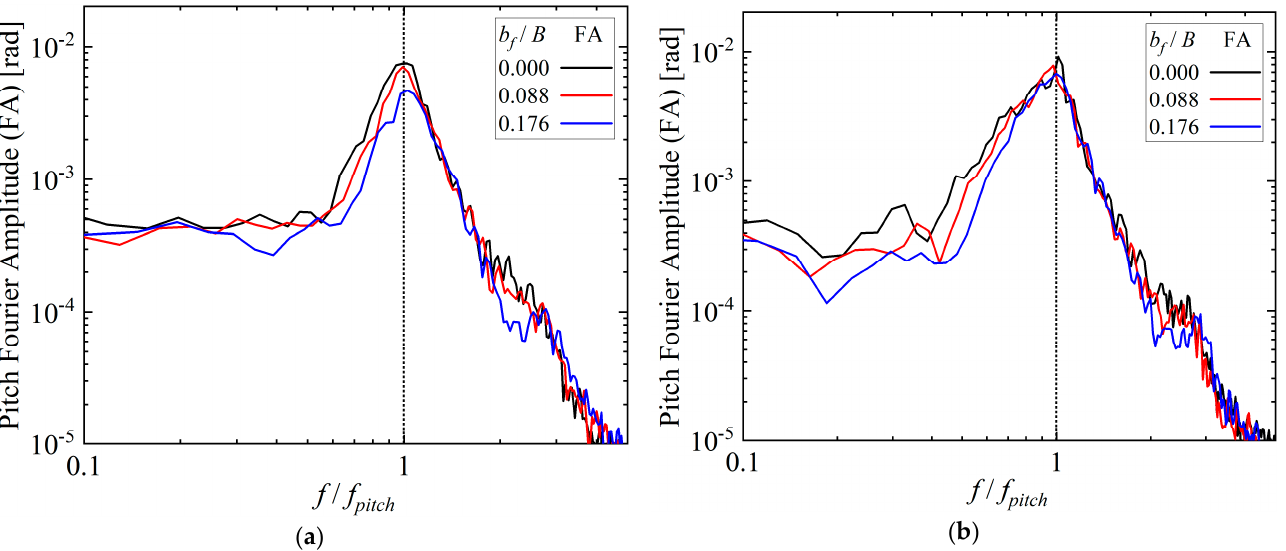
Figure 22. Fourier amplitude (FA) of the pitch with the normalized frequency f / f pitch for the irregular waves: ( a ) f s = 0.59 Hz; ( b ) f s = 0.44